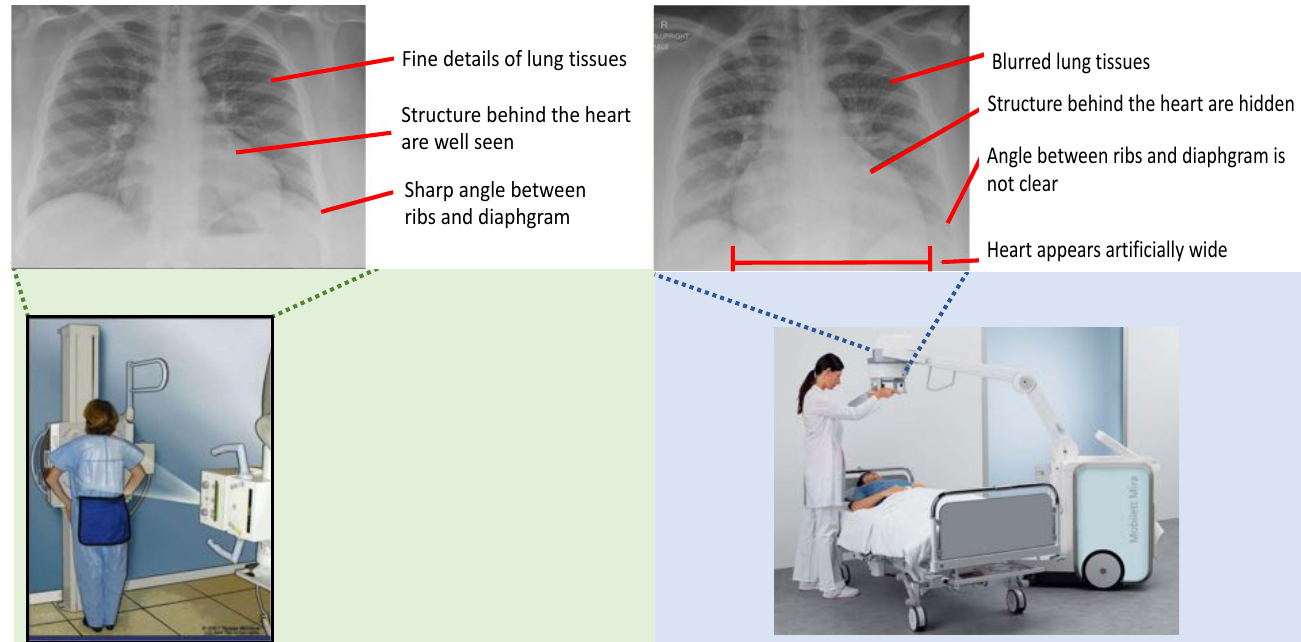
Figure 1. Comparison of conventional (left) vs. portable (right) CXR acquisition. The conventional CXR (left) is shown with high-quality details in lung tissue, well-defined structures behind the heart, and a sharp angle between the ribs and diaphragm. The portable CXR (right) shows degraded features, with blurred lung tissues, obscured structures behind the heart, a blurred angle between ribs and diaphragm, and an artificially wide appearance of the